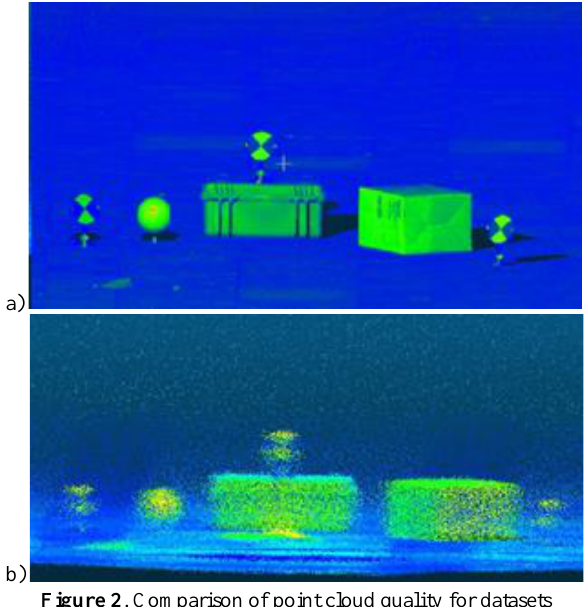
Figure 2 . Comparison of point cloud quality for datasets collected with scanners: RTC360 (a) and Livox Avia